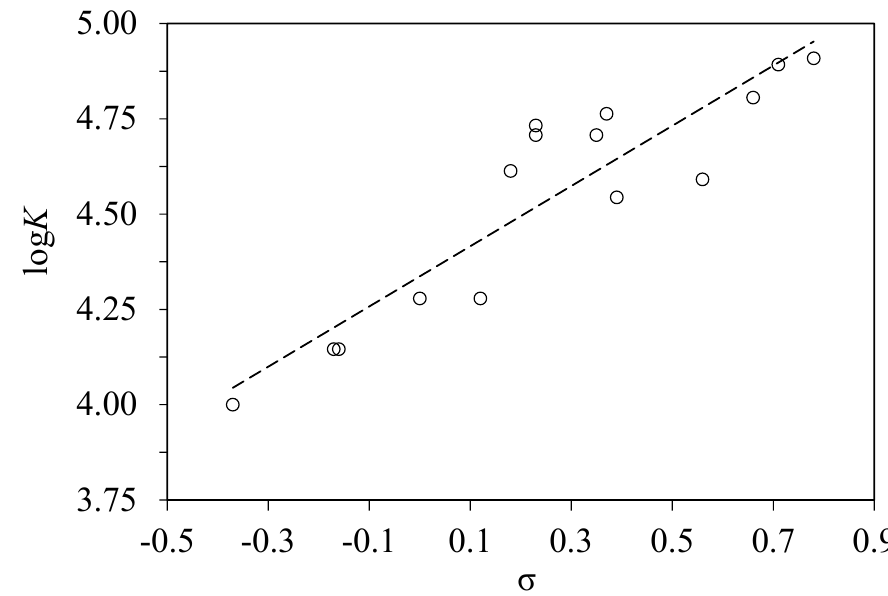
Figure 3. Correlation of the logarithms of binding constants log K of m- and p-monosubstituted benzoic acids to BSA with the Hammett constants σ [25] of the substituents.